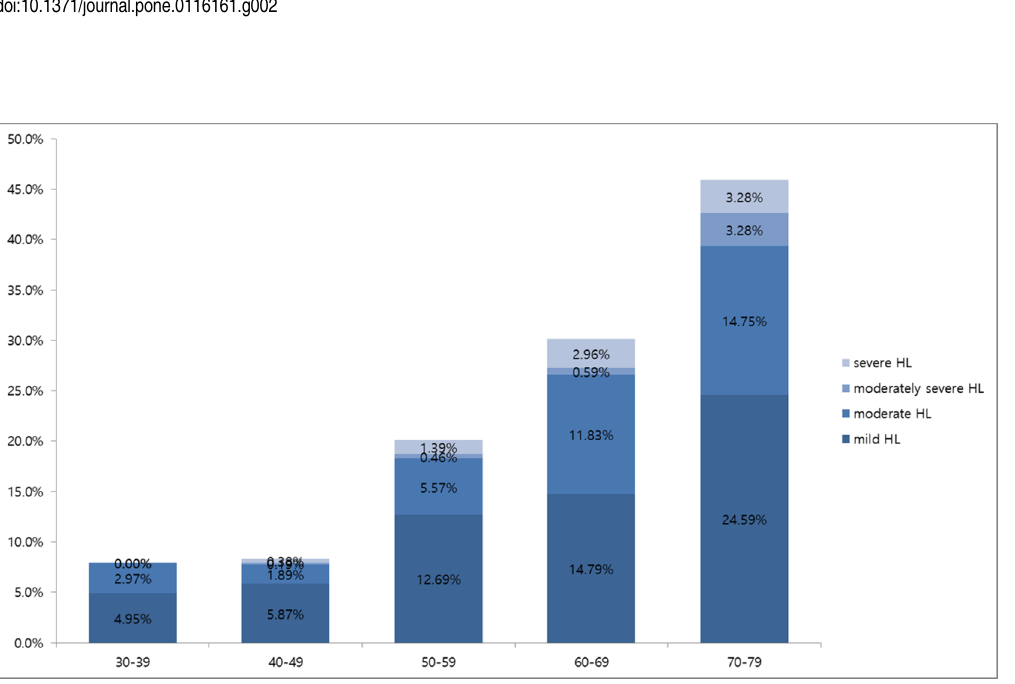
Fig. 2. Prevalence of hearing loss according to the severity of hearing loss by age group in subjects without DM.